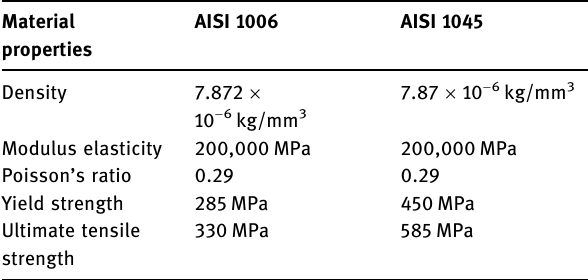
Table 1: Material physical properties for AISI 1006 and AISI 1045 Material properties